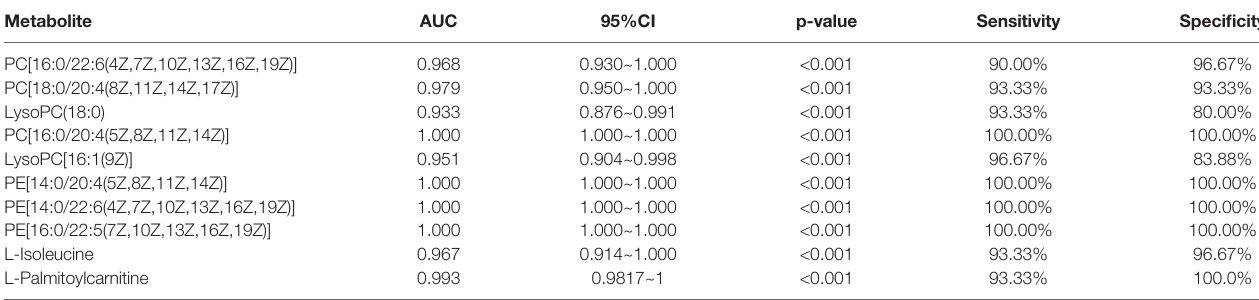
TABLE 3 | The diagnostic ef fi cacy of various metabolites in lung cancer.